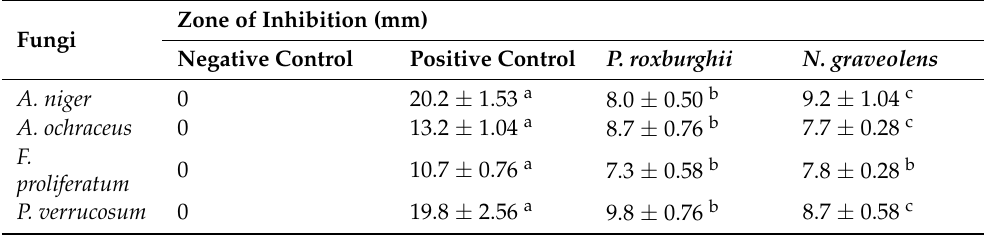
Table 5. Antifungal activity of P . roxburghii and N . graveolens extracts against mycotoxigenic fungi. Fungi